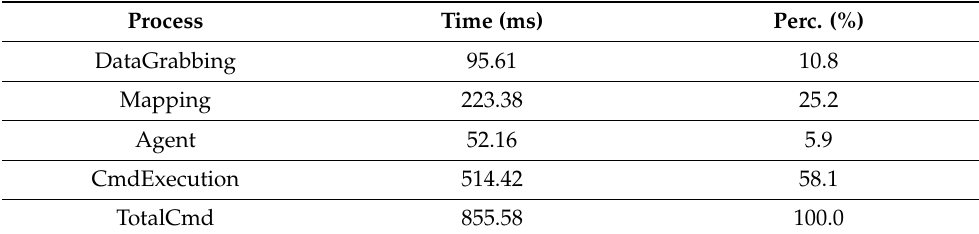
Table 7. Front-end interface process